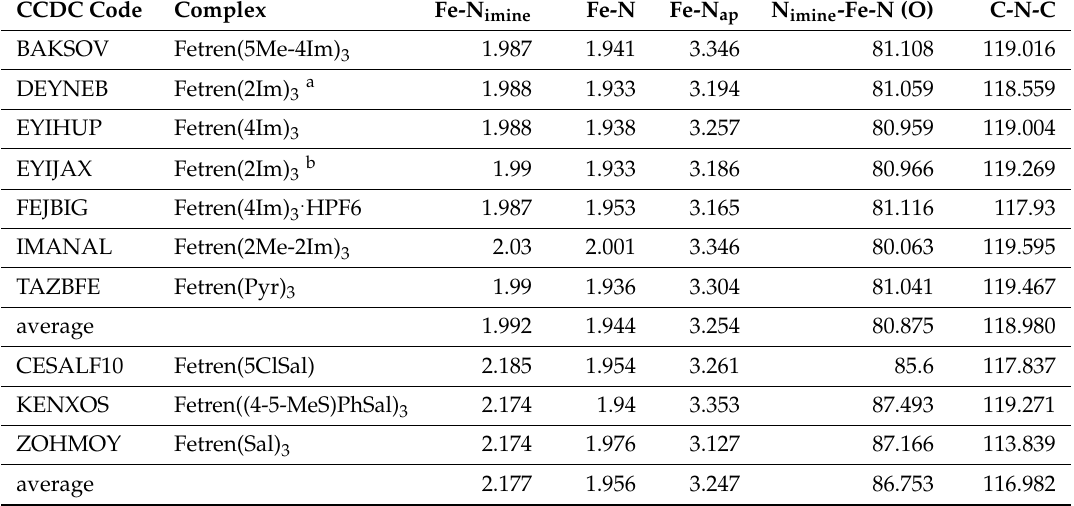
Table 4. Structural data for iron(III) neutral complexes. Distances are in Å and angles in ( ◦